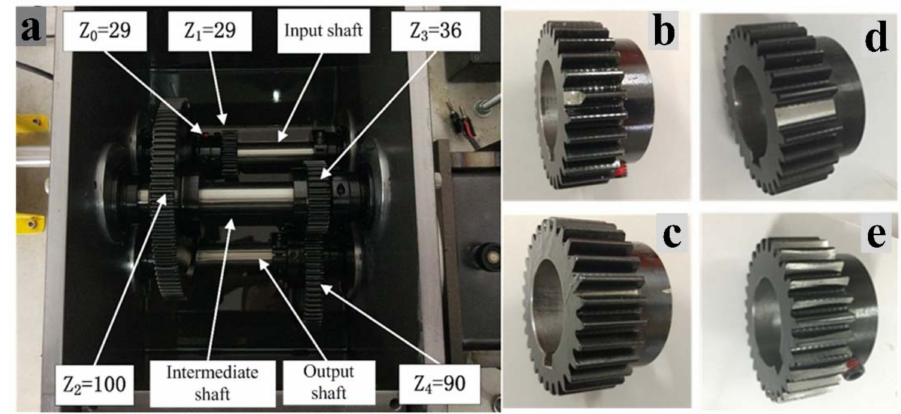
Figure 12. ( a ) The parameter of the two-stage parallel gearbox and gears used in the experiment with ( b ) a chipped tooth, ( c ) a tooth root crack, ( d ) a broken tooth, and ( e ) tooth surface abrasion.